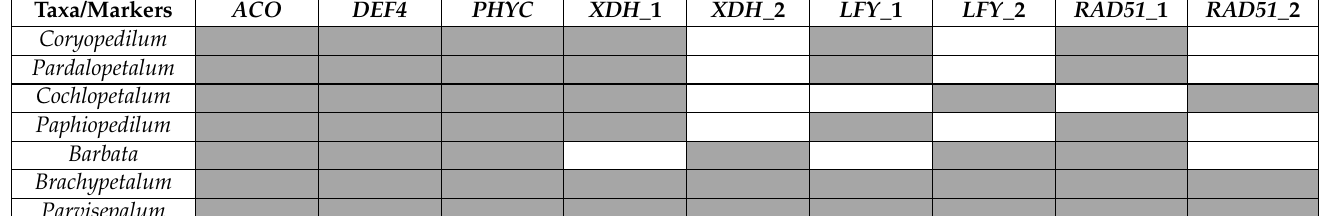
Table 3 . Combination of data partitions (nuclear-combined data matrix) and taxa used for phylogenetic analyses. Shaded boxes indicate sequences, and white boxes indicate excluded data (“missing data”) in the matrix.